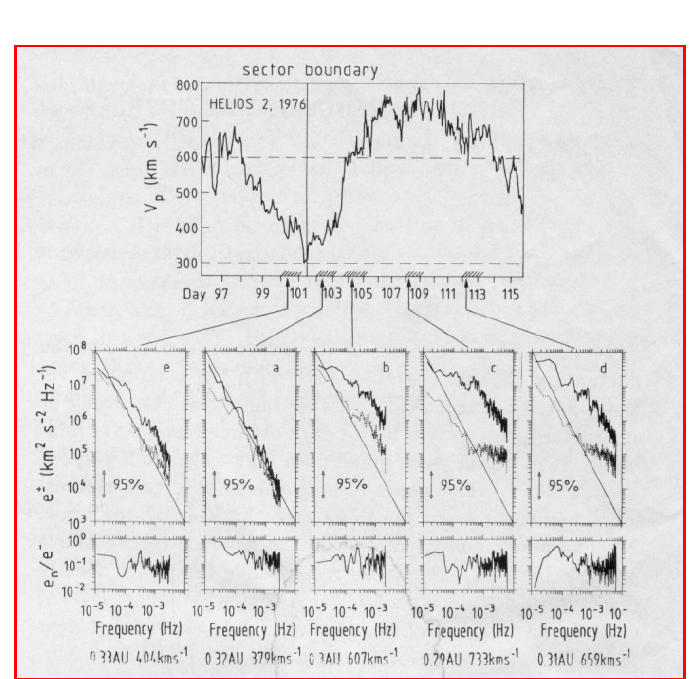
Figure 42: Power density spectra 𝑒 ± computed from 𝛿𝑧 ± fluctuations for different time intervals indicated by the arrows. Image reproduced by permission from Tu et al. (1990), copyright by AGU.